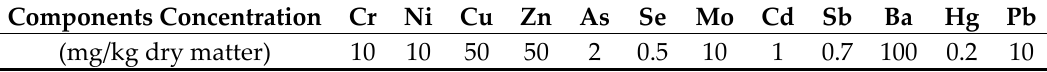
Table 1. Legal limit “Non-Hazardous” of EU Council Decision [9] to classify a waste as hazardous.